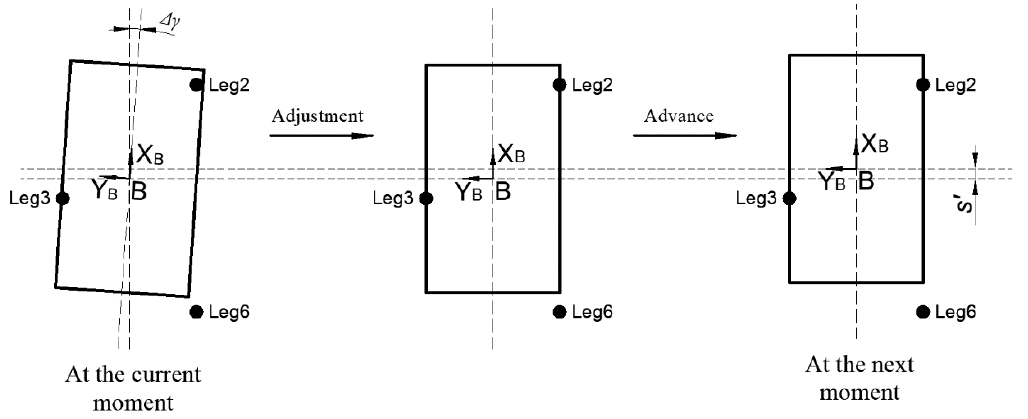
Figure 9. Kinematic model of yaw angle correction in straight gait.